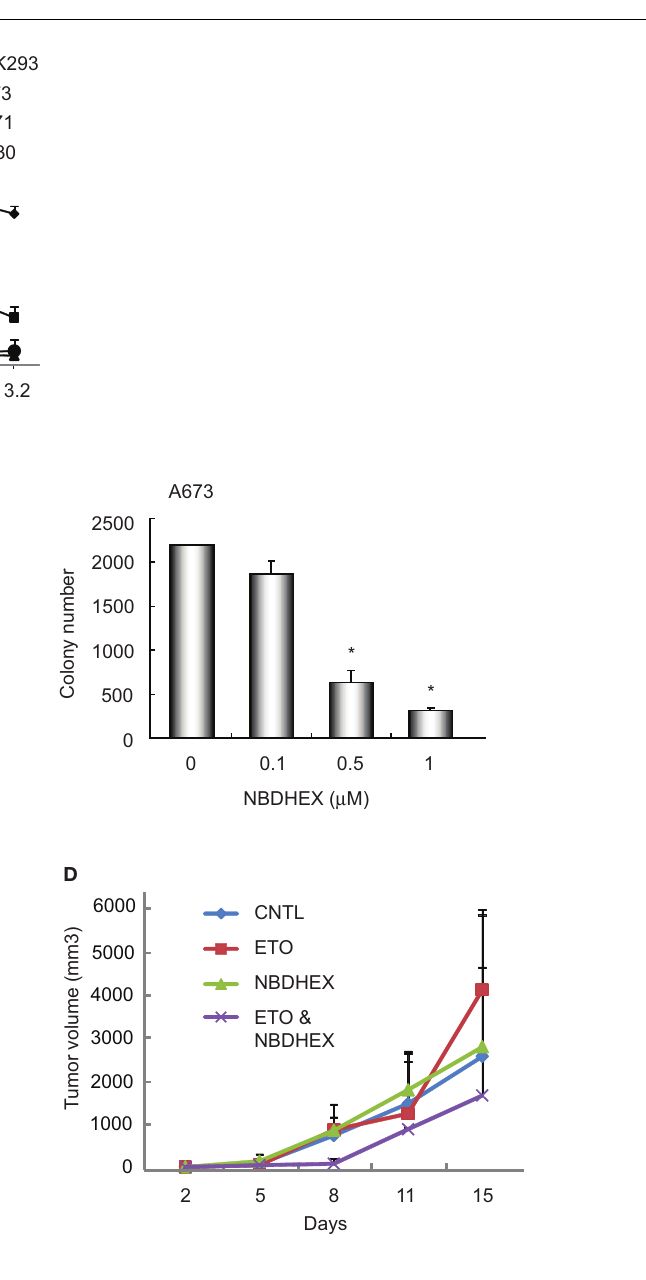
cytotoxicity of Ewing sarcoma cells. Cells were treated with NBDHEX, etoposide, or NBDHEX together with etoposide, as indicated. Cellular experiment was repeated three times and results of one representative repeat are shown as average of 10 tumors ± SD. ANOVA test indicates the differences in tumor growth between combination group and the other three groups are not statistically significant (p =